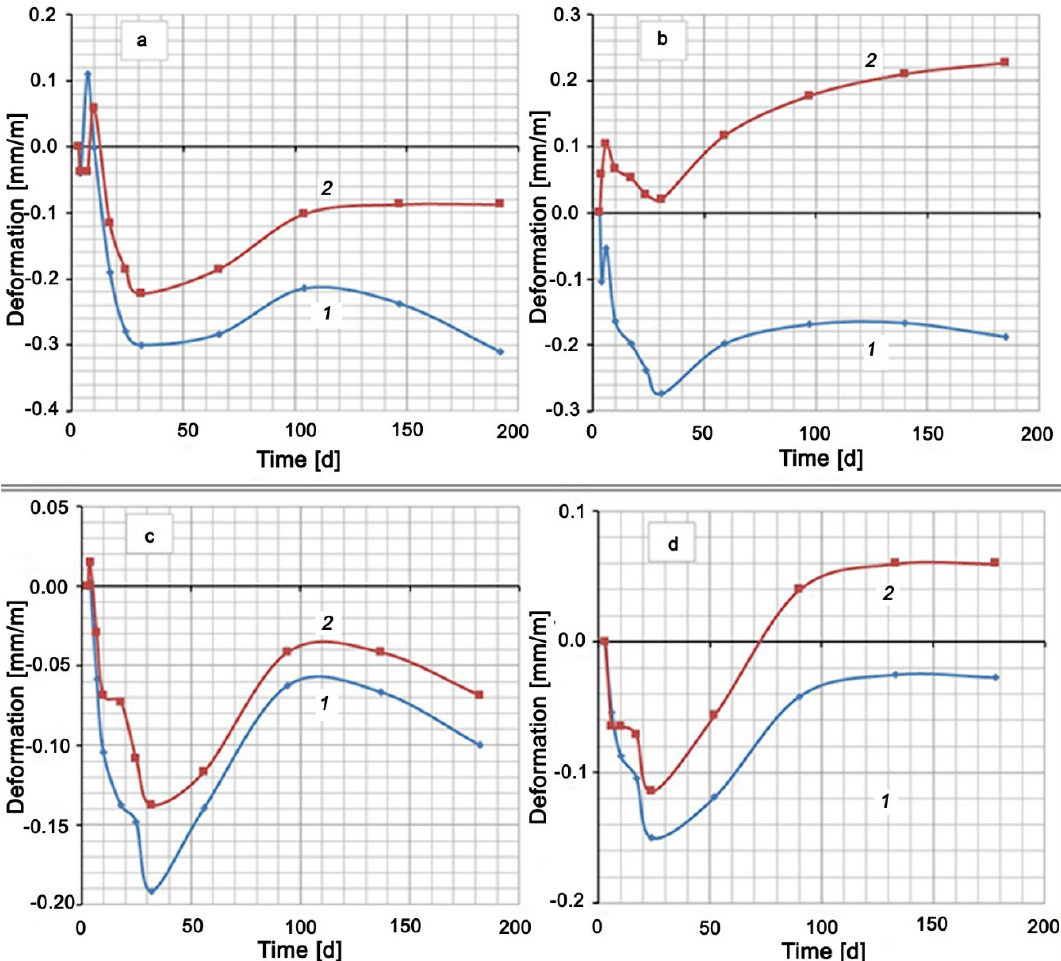
Figure 2. Shrinkage and expansion of compositions in time: ( a ) Control Mix; ( b ) mix with Zolest-bet additive (Mix No. 1); ( c ) mix with silica fume additive (Mix No. 2); ( d ) sulfate-resistant Portland cement (Mix No. 3); 1—at water hardening; 2—at 5% Na 2 SO 4 solution hardening.